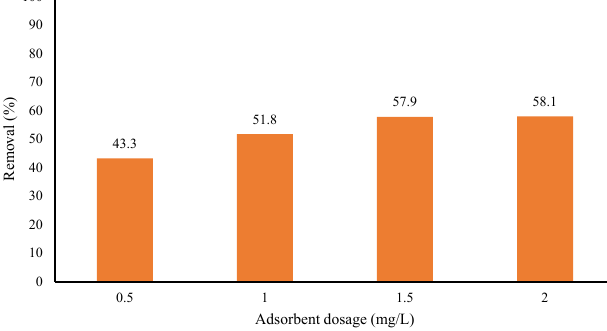
Fig. 3: Influence of bamboo activated carbon for removing nickel from electroplating industry wastewater against the adsorbent dosage